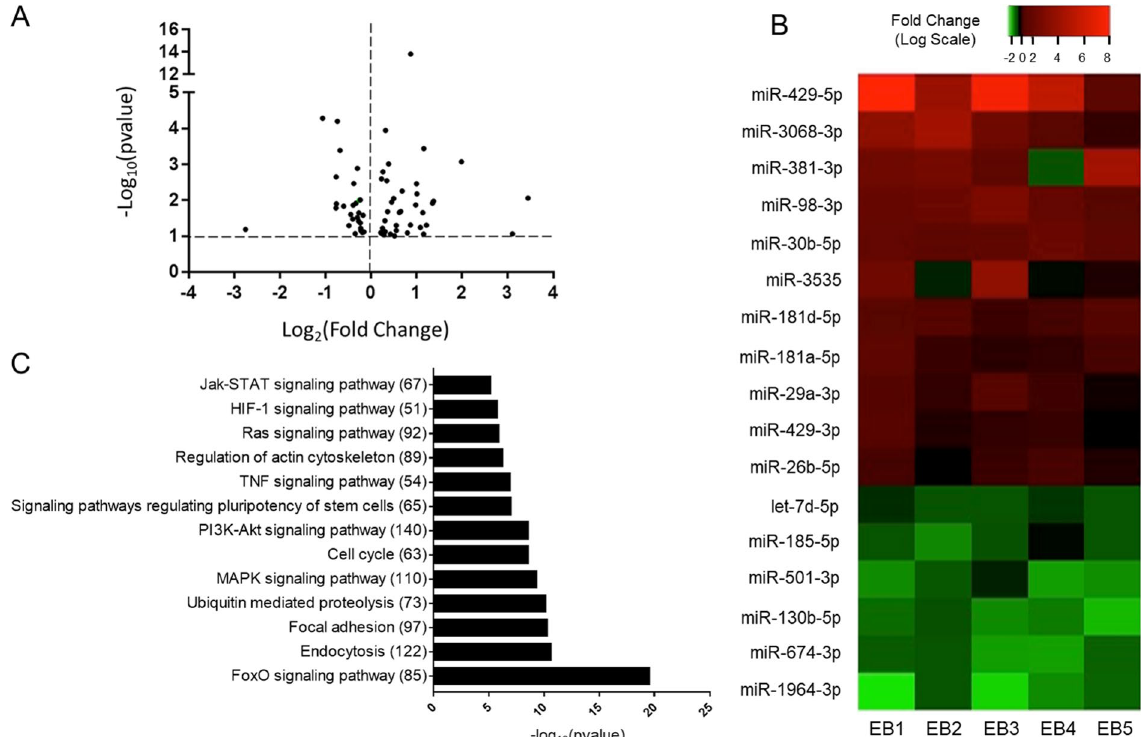
Figure 1. Small RNA sequencing analysis to identify differentially expressed microRNAs in small intestinal epithelial cells 1 day after alcohol and burn injury. ( A ) Volcano plot of differentially expressed microRNAs (p < 0.1) where each point on the graph represents an individual microRNA. Log2 fold change between ethanol burn and sham vehicle treated mice is plotted on the x-axis and the − log10 of the padj value is plotted on the y-axis. Overall, small RNA sequencing analysis identified 65 differentially expressed microRNAs (including 37 upregulated and 28 downregulated). ( B ) Heat map of fold change expression (log scale) of 17 differentially expressed miRNAs (DEMs) in each ethanol burn sample (EB1-5) relative to sham vehicle controls. Each row shows the fold change (log scale) of an individual DEM (padj < 0.1), ranging from downregulated (green) to upregulated (red) ( C ) KEGG pathway analysis of validated microRNA gene targets utilizing miRnet. Each bar represents a KEGG pathway, with the number of associated gene targets in parentheses, found to be significantly enriched (p value < 0.05) among the validated gene targets of the 17 DEMs outlined in ( B ).